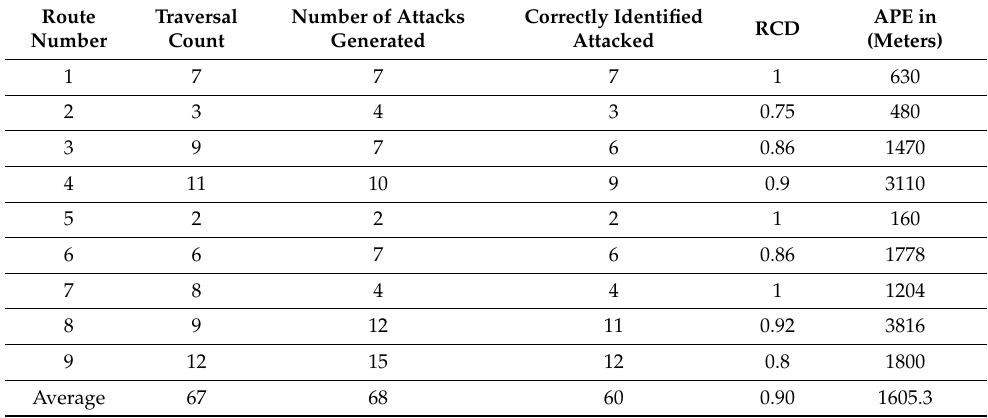
Table 4. Accuracy analysis of proposed approach using RCD and APE metrics. Route